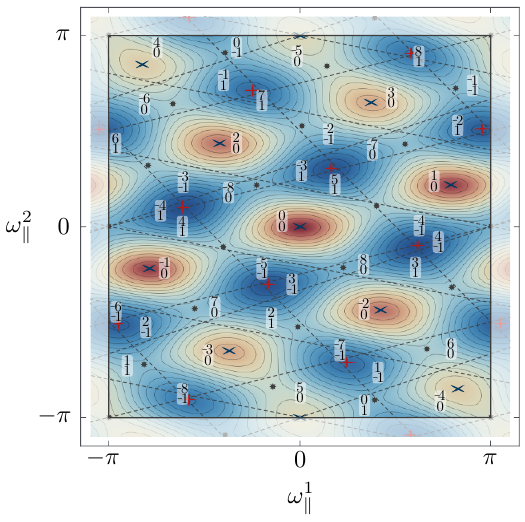
Figure 3 . Illustration of the tiling of the periodic domain of the physical potential induced by the intersections of the constraint surface with P -cubes surrounding lattice sites in the auxiliary lattice. We used P = N + 2 = 4 and labeled each distinct intersection by a P N = 2-vector. This (cid:0) example is well-aligned only in the direction t , corresponding to the upper label (if both directions 1 are well-aligned, the plot becomes too dense to be